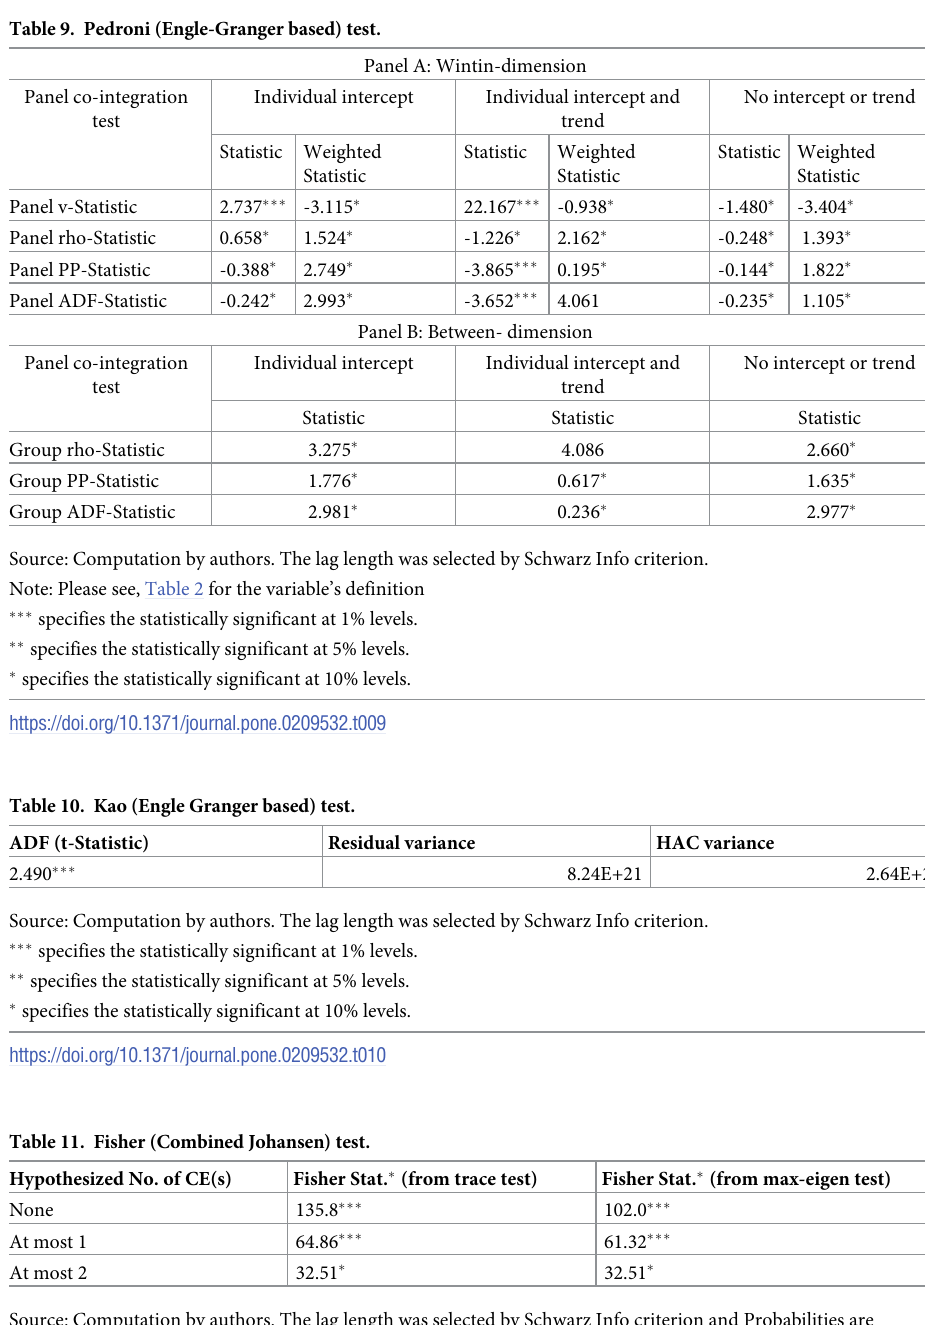
Table 9. Pedroni (Engle-Granger based) test.